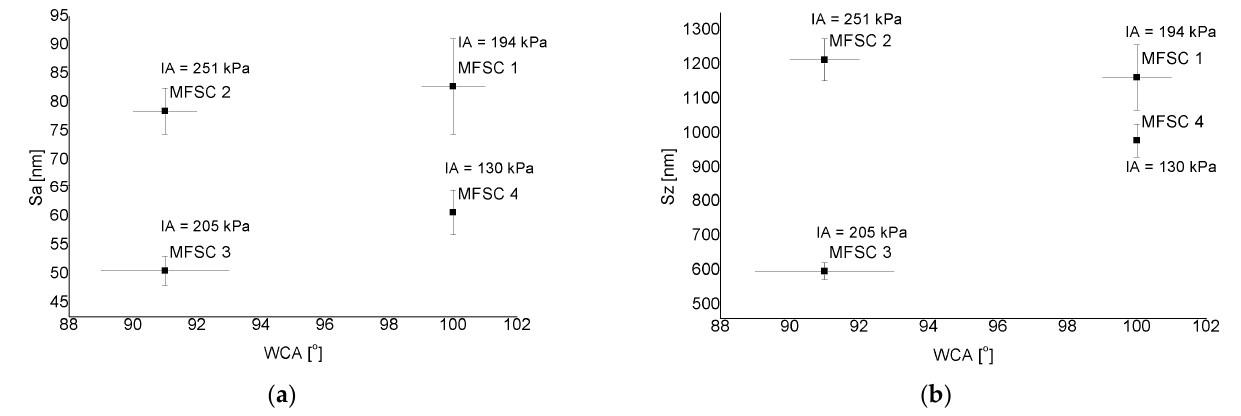
Figure 8. The relationship between water contact angle and ( a ) Sa, ( b ) Sz.